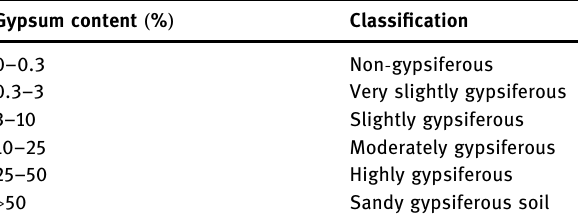
Table 1: Classi fi cation of gypseous soil [ 3 ]